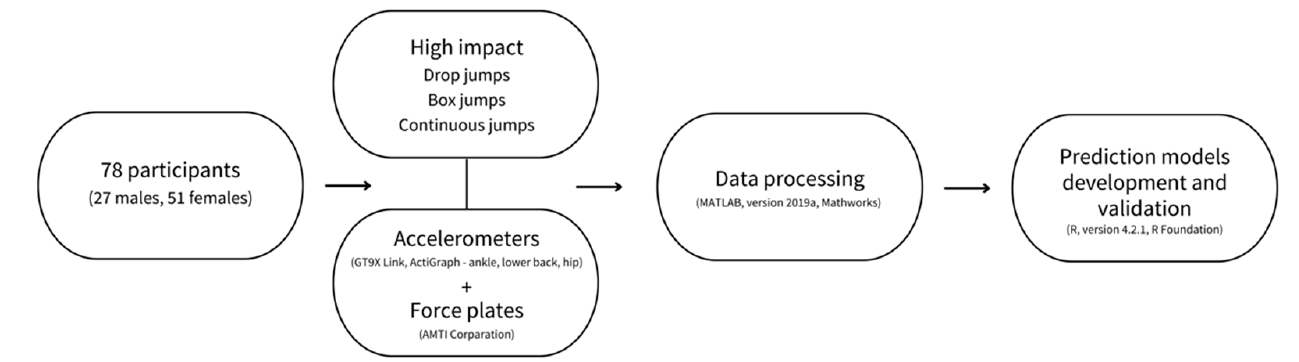
Figure 1. Overall scheme of the study design and methods employed in the study.